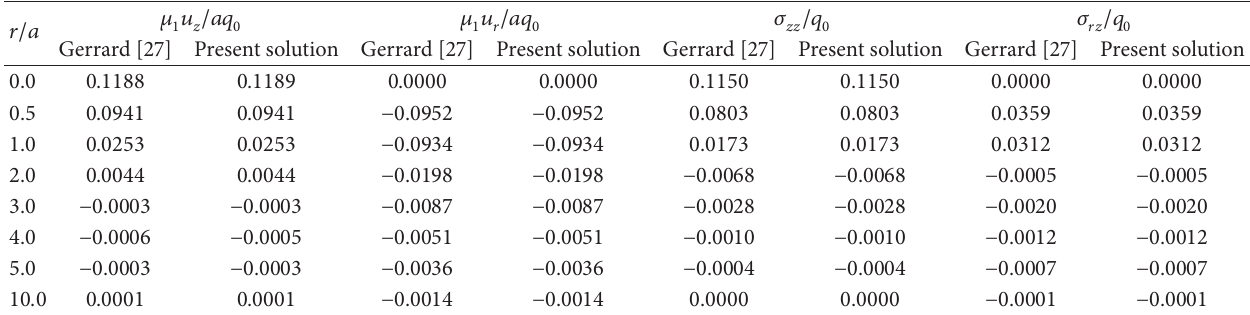
shear traction for 𝜇 1 /𝜇 2 = 5 and ℎ/𝑎 = 1